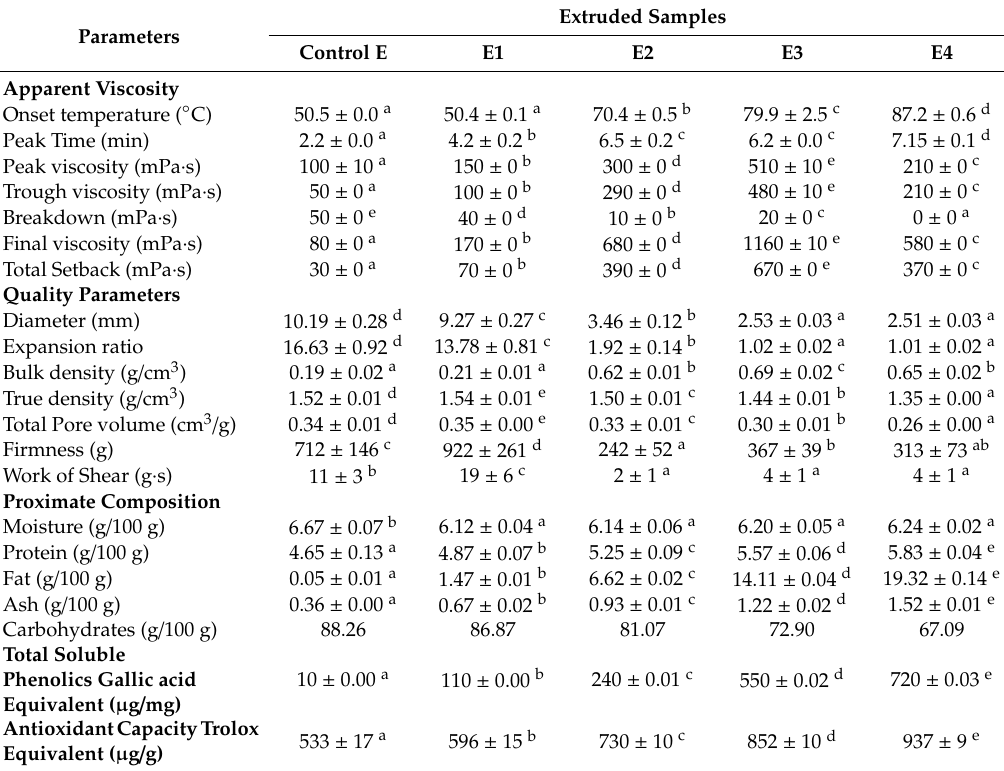
Figure 5. Rapid Visco Analyzer profiles of formulated extruded samples containing different levels of tiger nut flour. Table 2. Main physical and nutritional characteristics of extruded samples made from formulations with increasing concentrations of tiger nut flour (E1: 10%; E2: 30%; E3: 50%; E4: